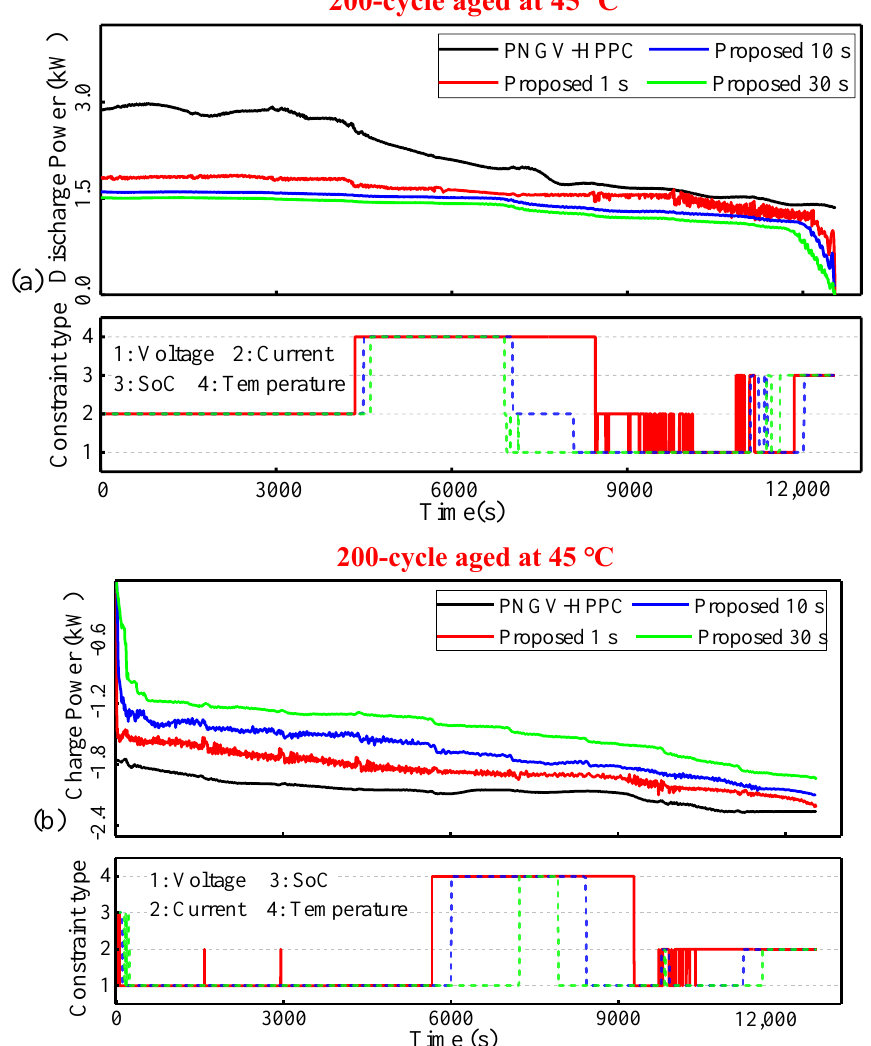
Figure 5. SoP prediction results with the active constraint on 200-cycle aged B2 at 45 ◦ C: ( a ) discharge Figure 5. S oP prediction results with the active constraint on 200-cycle aged B2 at 45 °C: ( a ) discharge